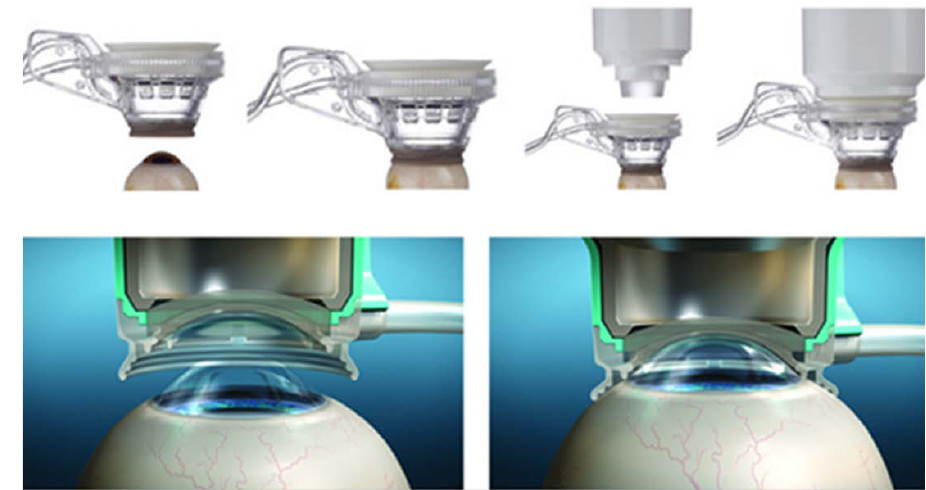
Figure 2. Schematic diagram of the placement of the suction ring on the corneal surface.